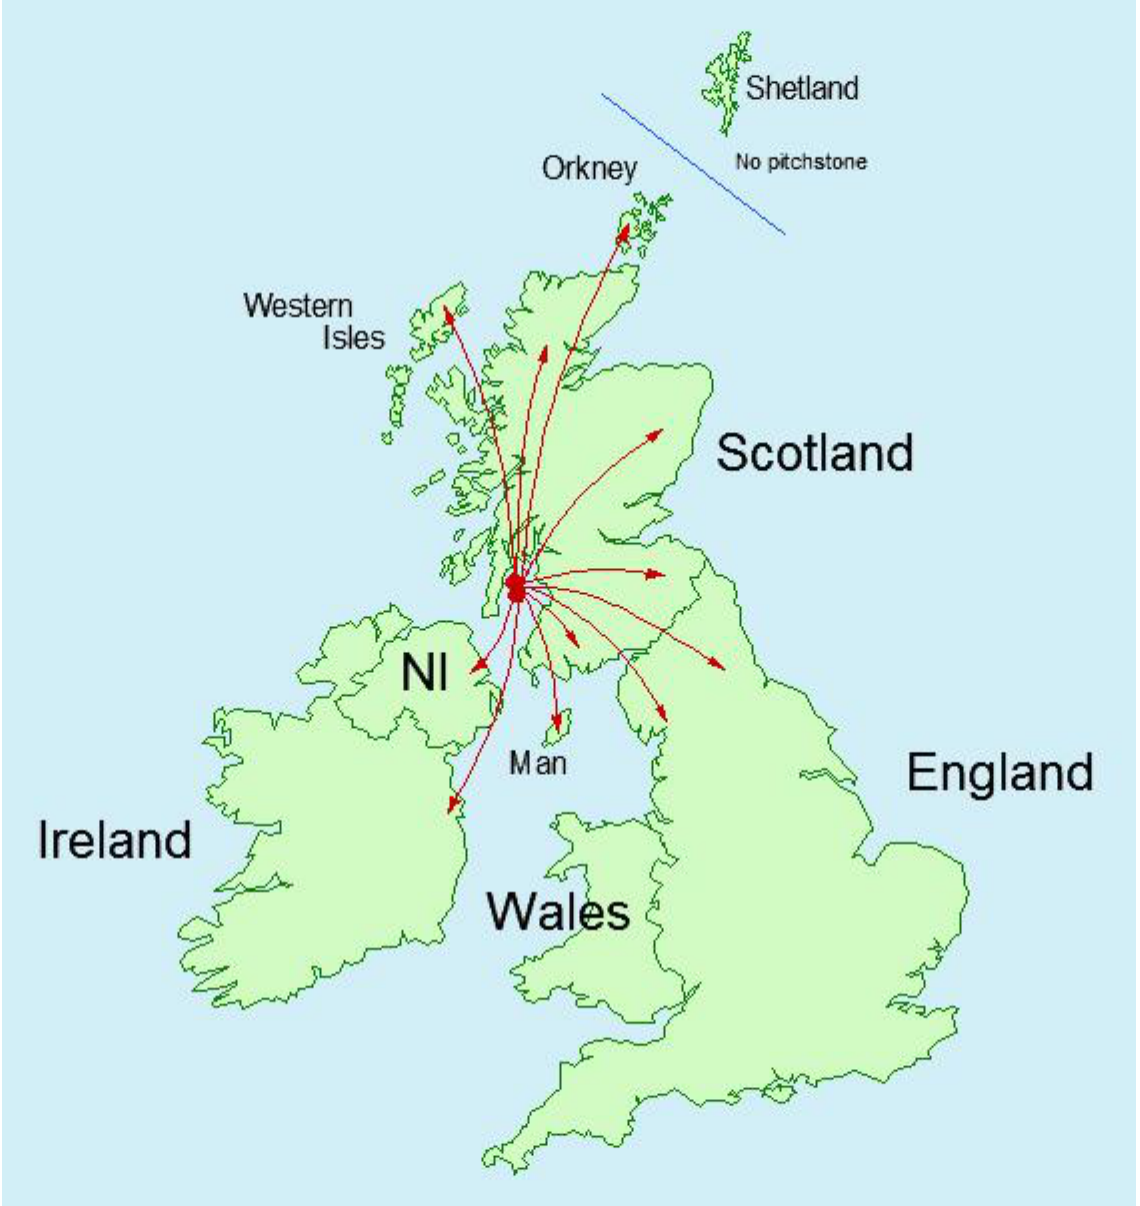
Figure 2. The distribution of archaeological pitchstone across northern Britain from the Isle of Arran in the Firth of Clyde, west of Glasgow. The only part of northern Britain where pitchstone artefacts have not been recovered is Shetland, where a marked insularity in the use of raw materials is evident (Ballin 2011c). The distance from Arran to Orkney is c. 400km. Pitchstone is expected – in due course of time – to be identified in assemblages further towards the south where it may have been misidentified as black chert, black flint, jet or glassy slag (Ballin